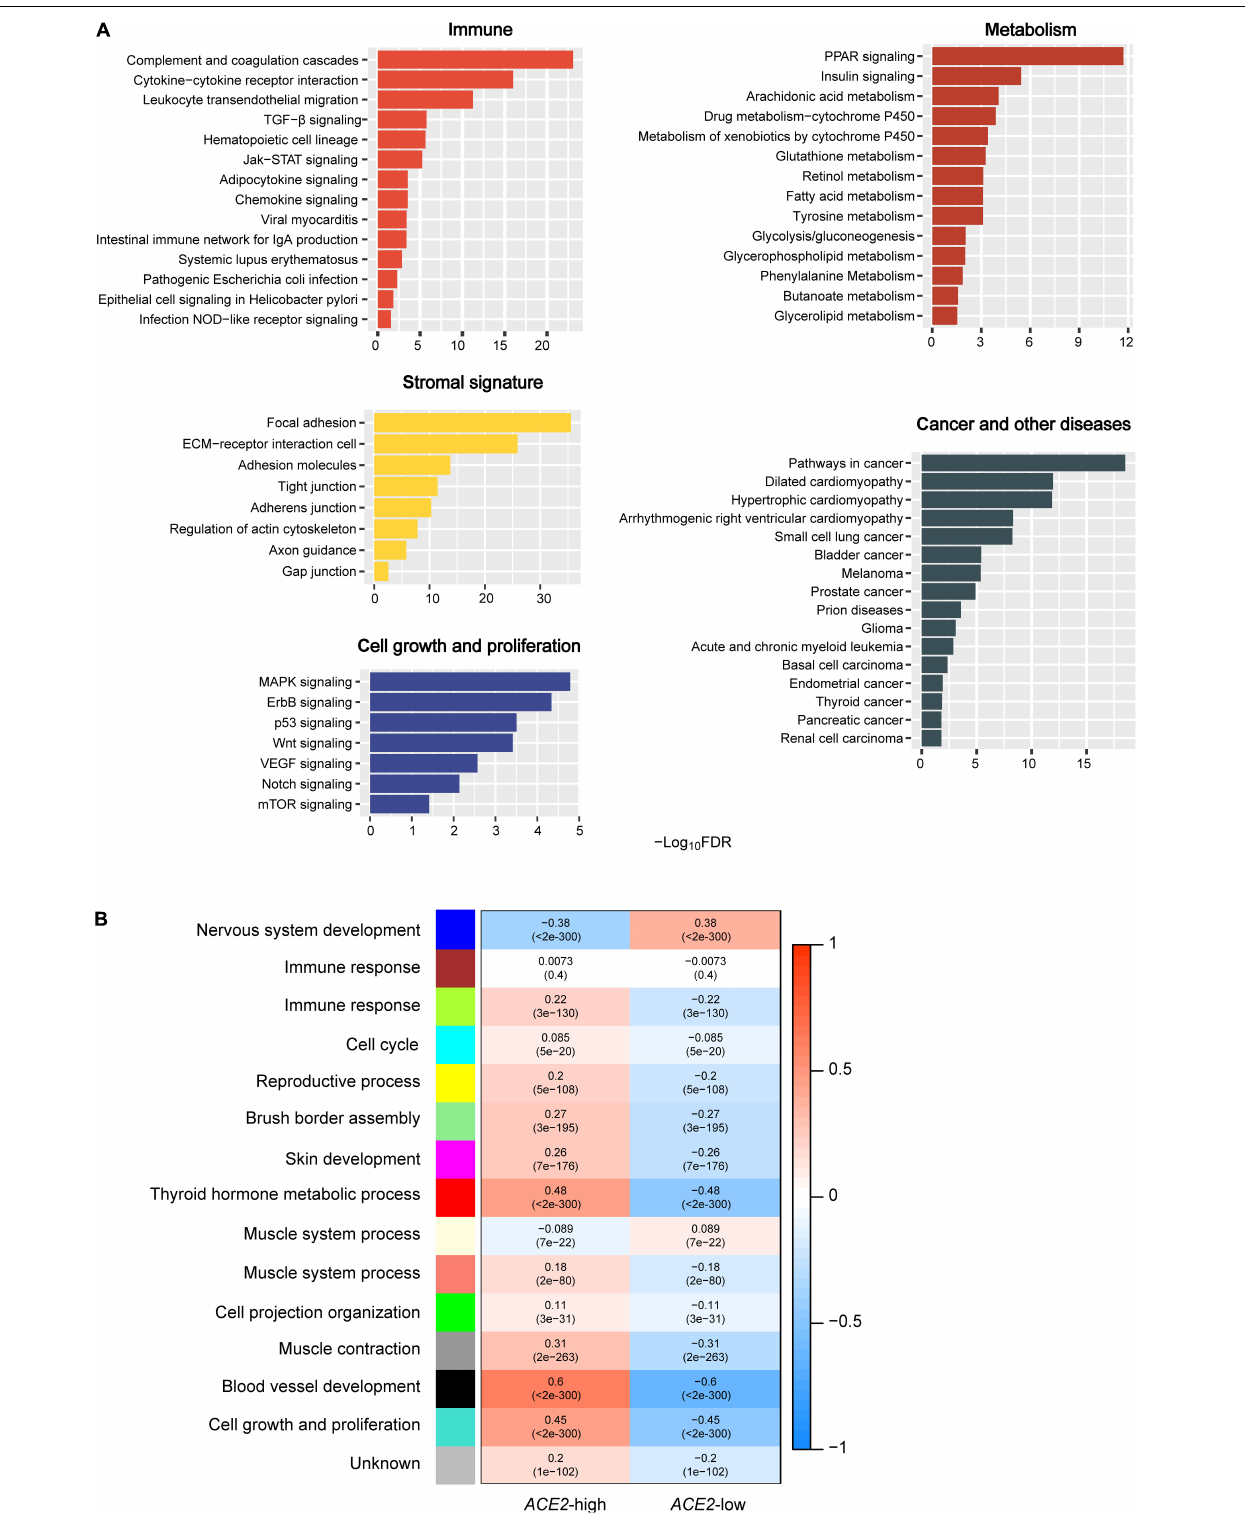
FIGURE 1 | Pathways and gene ontology associated with ACE2 expression. (A) The KEGG pathways significantly associated with ACE2 upregulation identified by GSEA (Subramanian et al., 2005). (B) Gene ontology significantly associated with ACE2 upregulation and downregulation identified by WGCNA (Langfelder and Horvath,